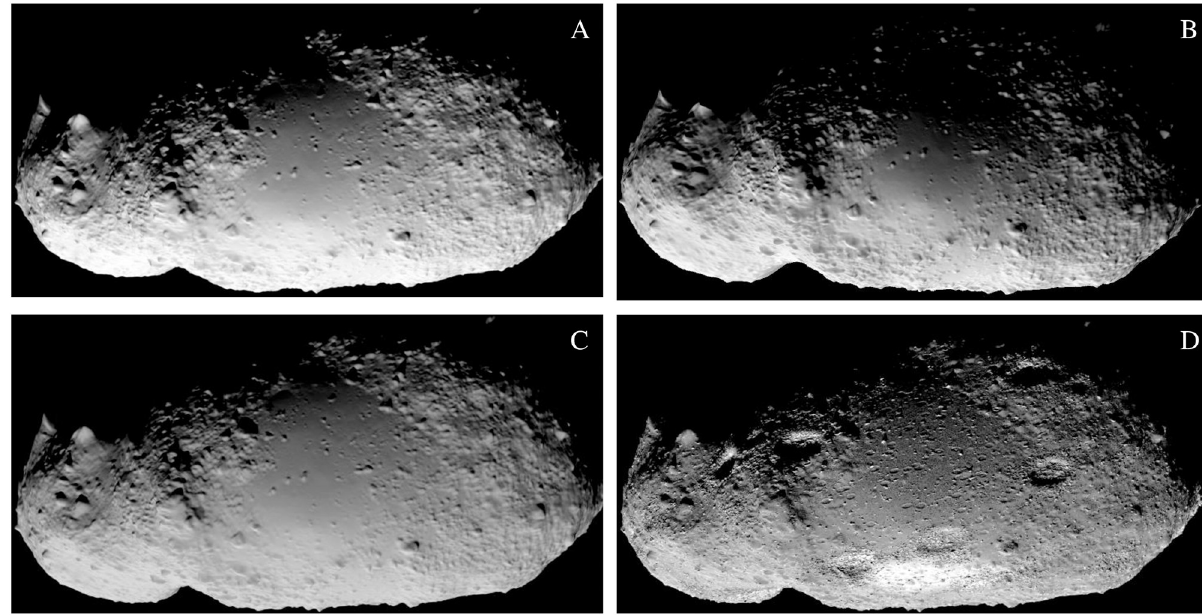
Fig 1. The comparison of available simulators for space-scene image rendering. The rendered example for each simulator is asteroid 25143 Itokawa. (A) SurRender image generator by Airbus; it uses backward ray tracing or image generation with Open Graphics Library (OpenGL). (B) PANGU image generator by University of Dundee, UK and ESA; it uses fractal terrain generation using OpenGL. (C) SISPO by the University of Tartu, Estonia and Aalto University, Finland; it uses Blender Cycles physically based path tracer (the same model as above with a simple diffuse shader); (D) SISPO with Blender Cycles physically based path tracer (with procedural displacement with new surface features and reflectance textures for extra detail).